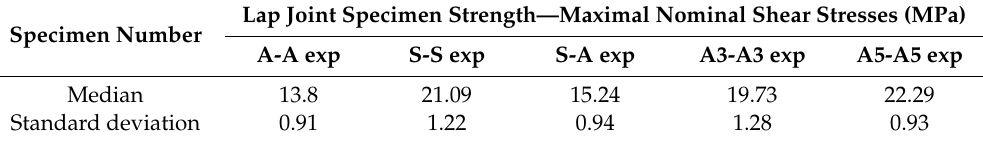
Table 5. Test results for single-lap joint specimens.